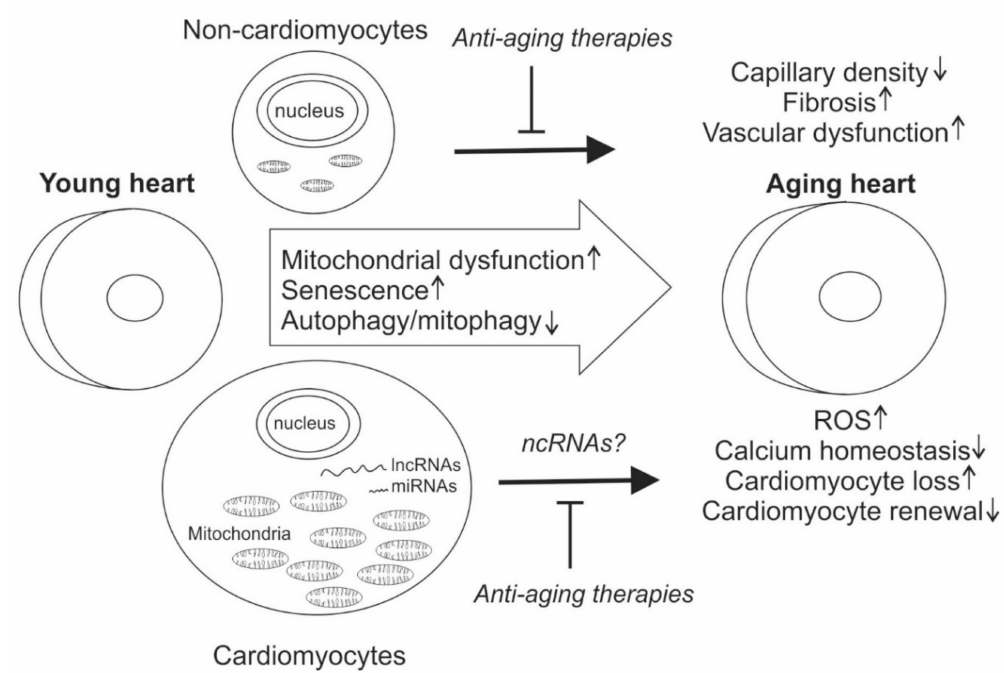
Figure 1. Molecular and cellular events contributing to cardiac aging. Heart consists > 70% cardiomyocytes in terms of volume, whereas the turnover rate of cardiomyocytes is low. A high number of mitochondria in the cardiomyocytes serves as a major source for reactive oxygen species (ROS). Cardiac aging features abnormal calcium homeostasis, loss of cardiomyocytes, senescence and reduced cardiomyocyte renewal. Aging in non-cardiomyocytes leads to reduced capillary density, cardiac fibrosis and vascular dysfunction. Mitochondrial dysfunction, accumulation of senescent cells and impaired autophagy / mitophagy are typical cellular features of cardiac aging. Current anti-aging therapies are mainly aimed at removing senescent cells, but the targeted cell composition and the e ff ect on cardiac function is largely unknown. MicroRNAs (miRNAs) and long non-coding RNAs (lncRNAs) play critical roles in regulating cardiomyocyte function and there is increasing evidence